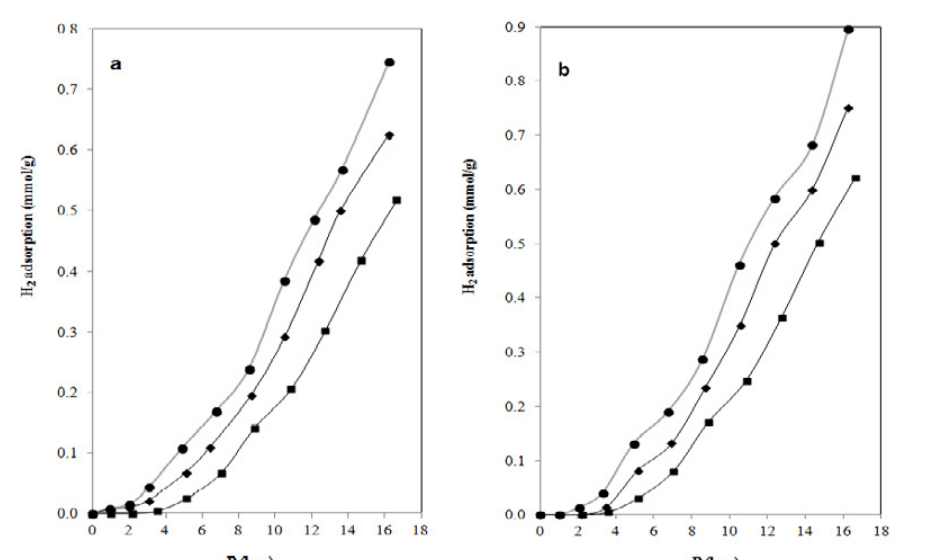
Fig. 7. Hydrogen adsorption isotherms of the graphene oxide (a) and g-C